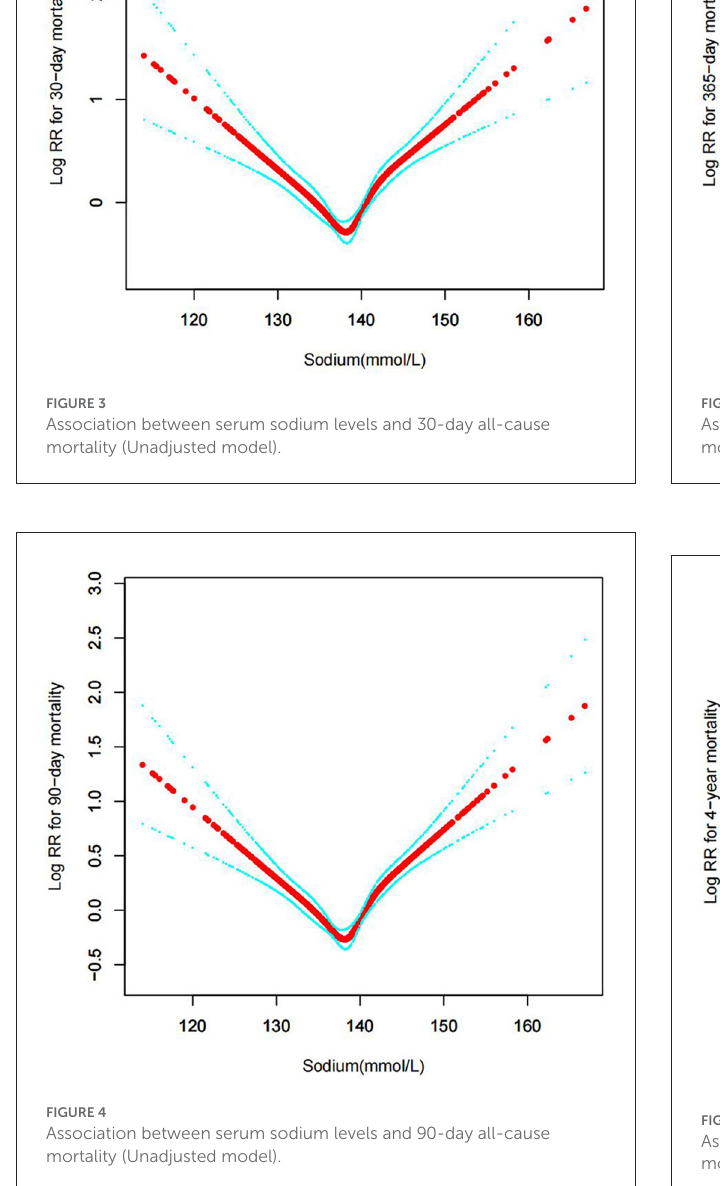
Clinical congestive heart failure most frequently manifests as left heart failure, and the clinical features of left heart failure are mainly due to pulmonary congestion and pulmonary edema caused by left atrial failure and right ventricular failure (17). The clinical feature of right heart failure is that due to right atrial and ventricular failure caused by congestion of the veins in the systemic circulation and retention of water and sodium, the right heart frequently has functional impairment following the beginning of left heart failure, which ultimately leads to total heart failure (18). Sodium ions are very important cations in the extracellular fluid of the human body, and over 90% of the total ions in the extracellular fluid are sodium ions.